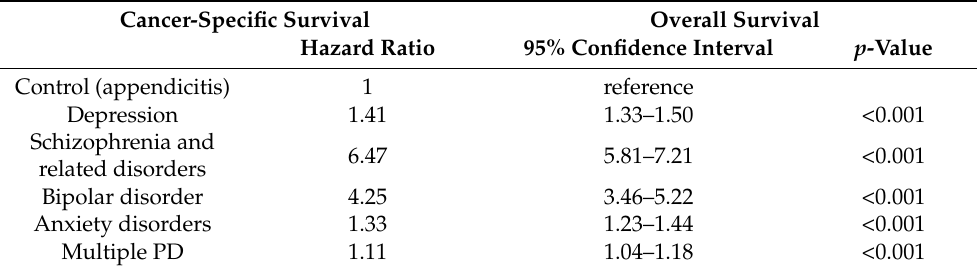
Table 2. Cox regression model used to estimate the effects of having a PD on survival.